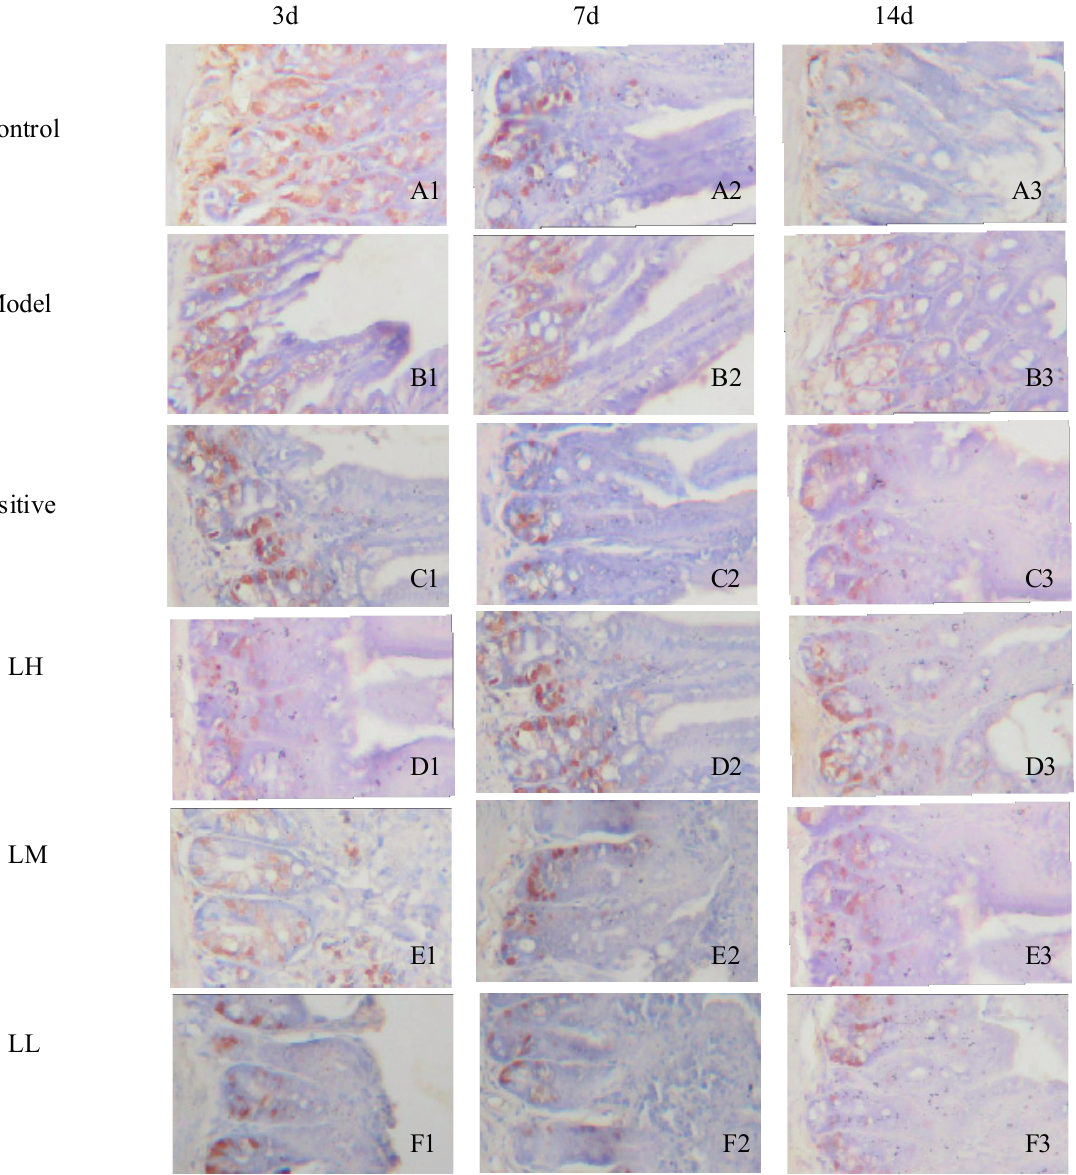
Figure 7. Expression of P53 in the intestinal epithelial cells (Obj.